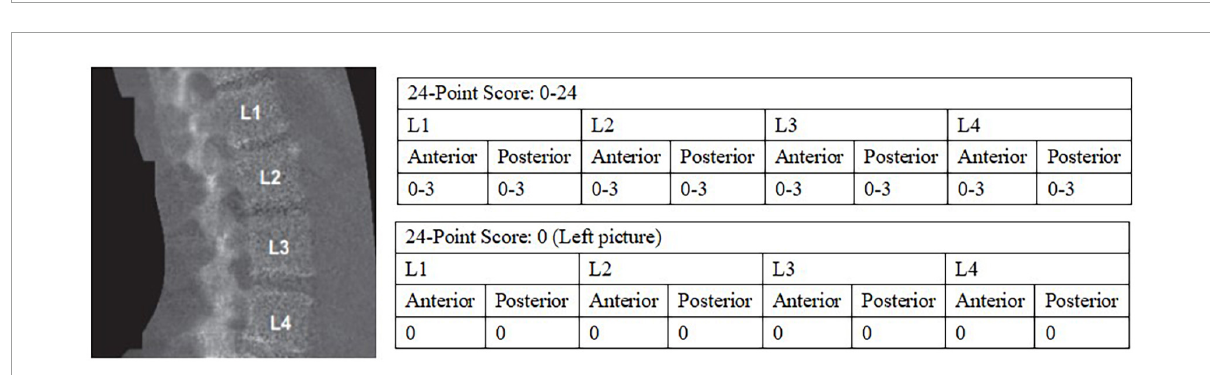
FIGURE2 24-point semi-quantitative AAC scale and image by DXA (33). AAC, abdominal aortic calcification; DXA, dual-energy X-ray absorptiometry.